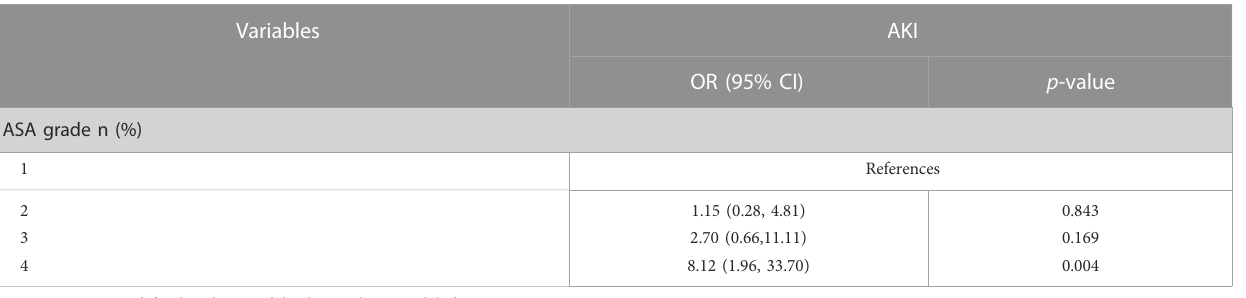
ACEI, CCB, etc. , was de fi ned as the use of the drug within 1 week before surgery. Abbreviations: AKI, acute kidney injury; BMI, body mass index; ACEI, angiotensin-converting enzyme inhibitor; CCB, calcium-channel blockers; NSAIDs, non-steroidal anti-in fl ammatory drugs; eGFR, estimated glomerular fi ltration rate; MAP, mean arterial pressure; ASA, american society of anesthesiologist.